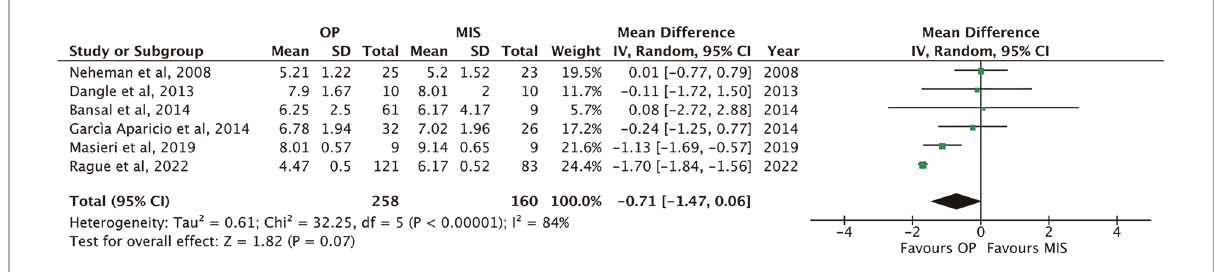
FIGURE 3 Forest plot comparison of weight at procedure between OP and MIS in